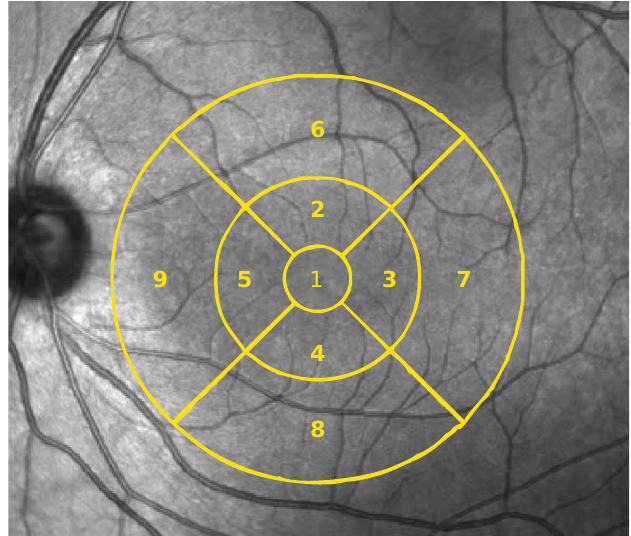
Figure 1. Early Treatment Diabetic Retinopathy Study (ETDRS) grid overlying the macula. Nine subfields are represented. 1 = center, 2 = inner superior, 3 = inner right, 4 = inner inferior, 5 = inner left, 6 = outer superior, 7 = outer right, 8 = outer inferior, 9 = outer left.